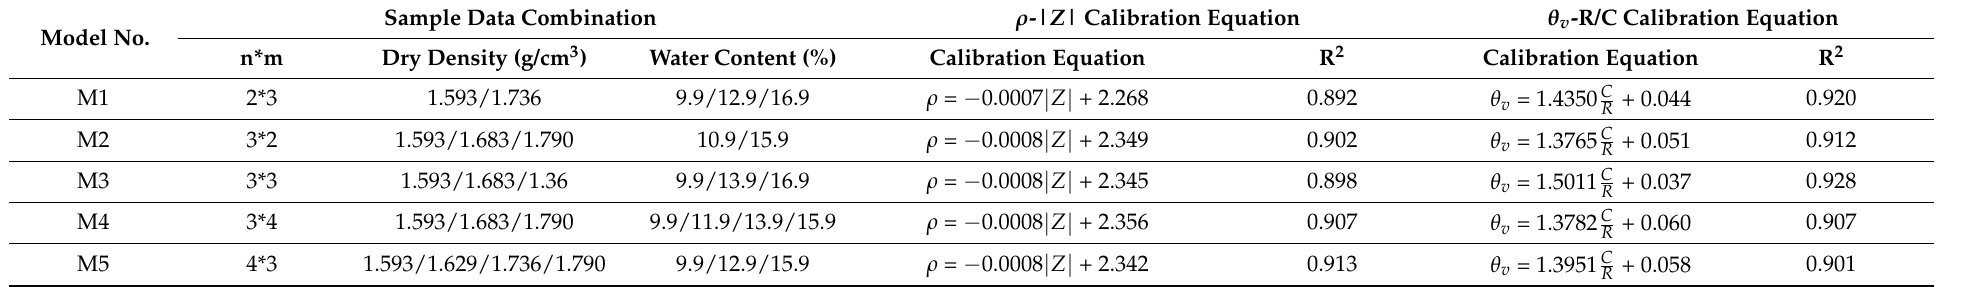
Table 7. Models to verify the accuracy of soil calibration